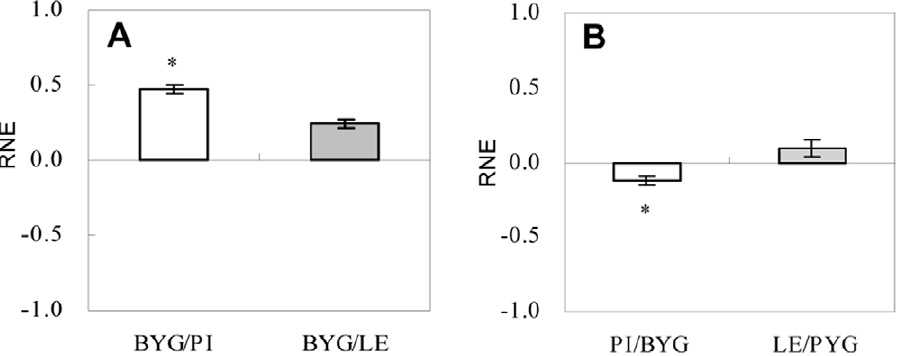
Figure 1. Relative neighbor effect (RNE) of each of the two rice accessions and barnyardgrass in rice/BYG mixed-cultures. A – RNE of BYG in mixed-cultures with PI and with LE. B – RNE of PI and LE in mixed-cultures with BYG. PI – rice accession PI312777; LE – rice accession Lemont. BYG – barnyardgrass. * –significantly different in different treatment groups ( P , 0.05).